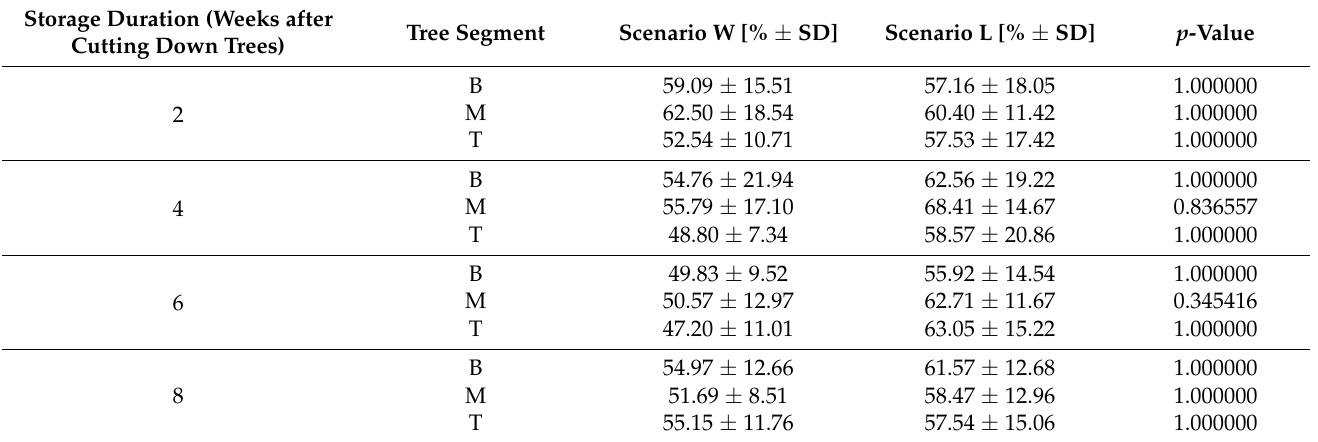
Table 6. Mean and standard deviation of sapwood moisture content (sMC) according to part of the experiment, storage methods and tree segments.